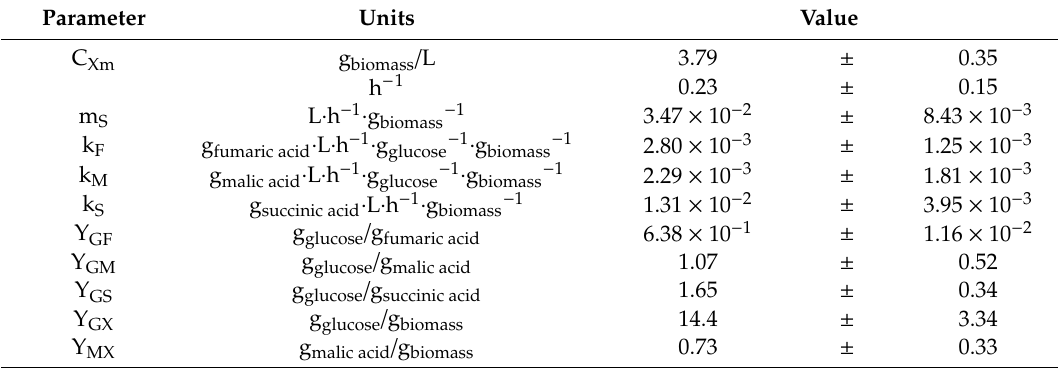
Table 2. Kinetic parameters of proposed